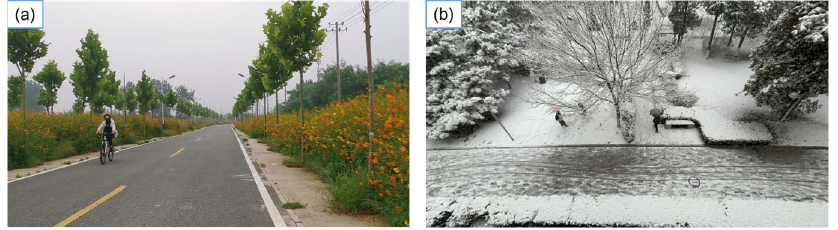
Figure 22. Generated caption: ( a ) “a man is riding a skateboard down a paved road”; ( b ) “a person is in the middle of a waterfall”.